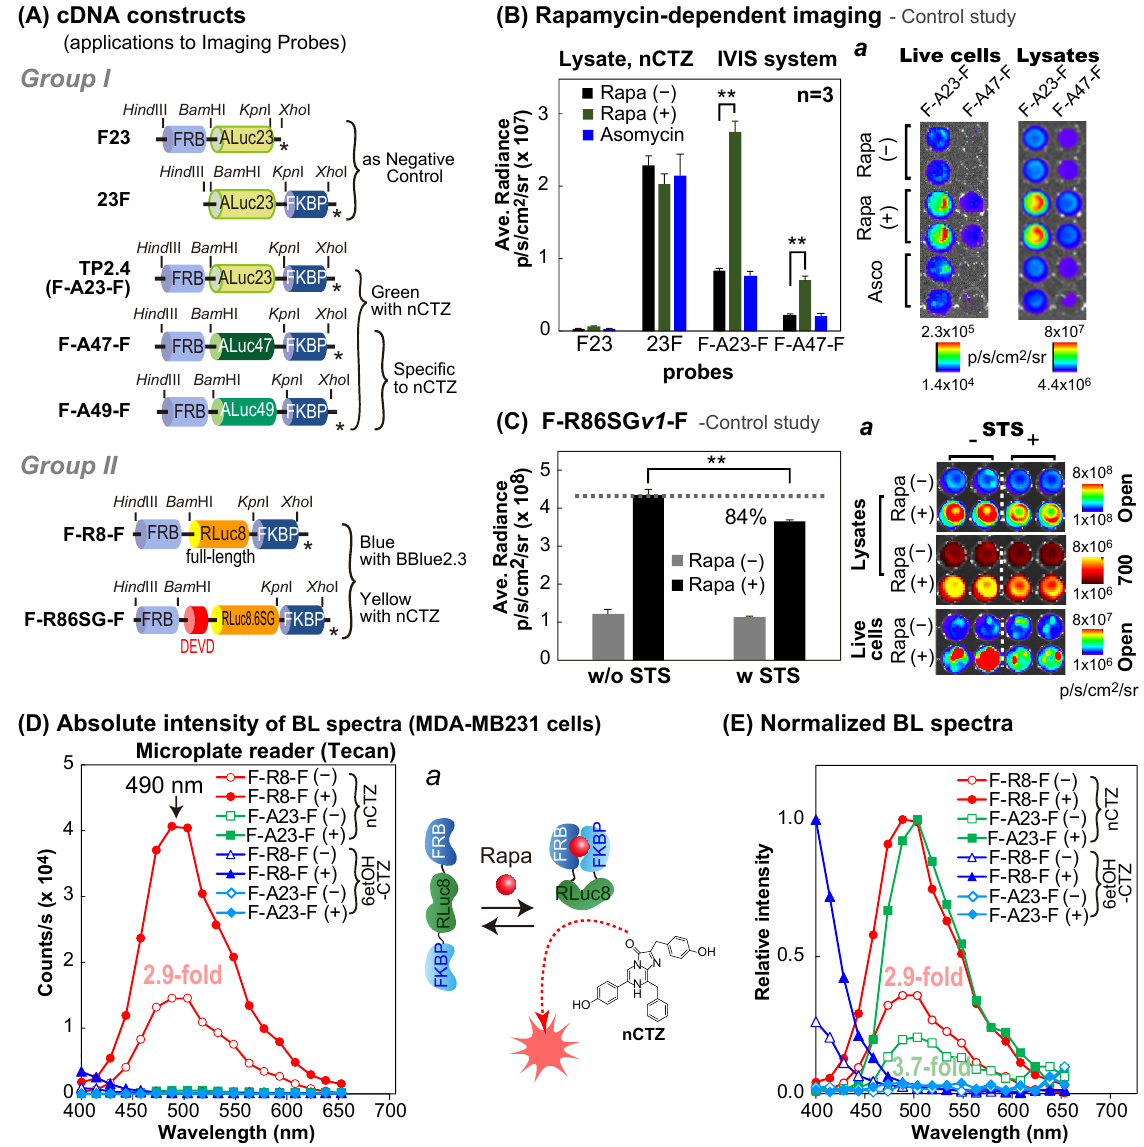
(A) cDNA constructs (B) Rapamycin-dependent imaging - Control study